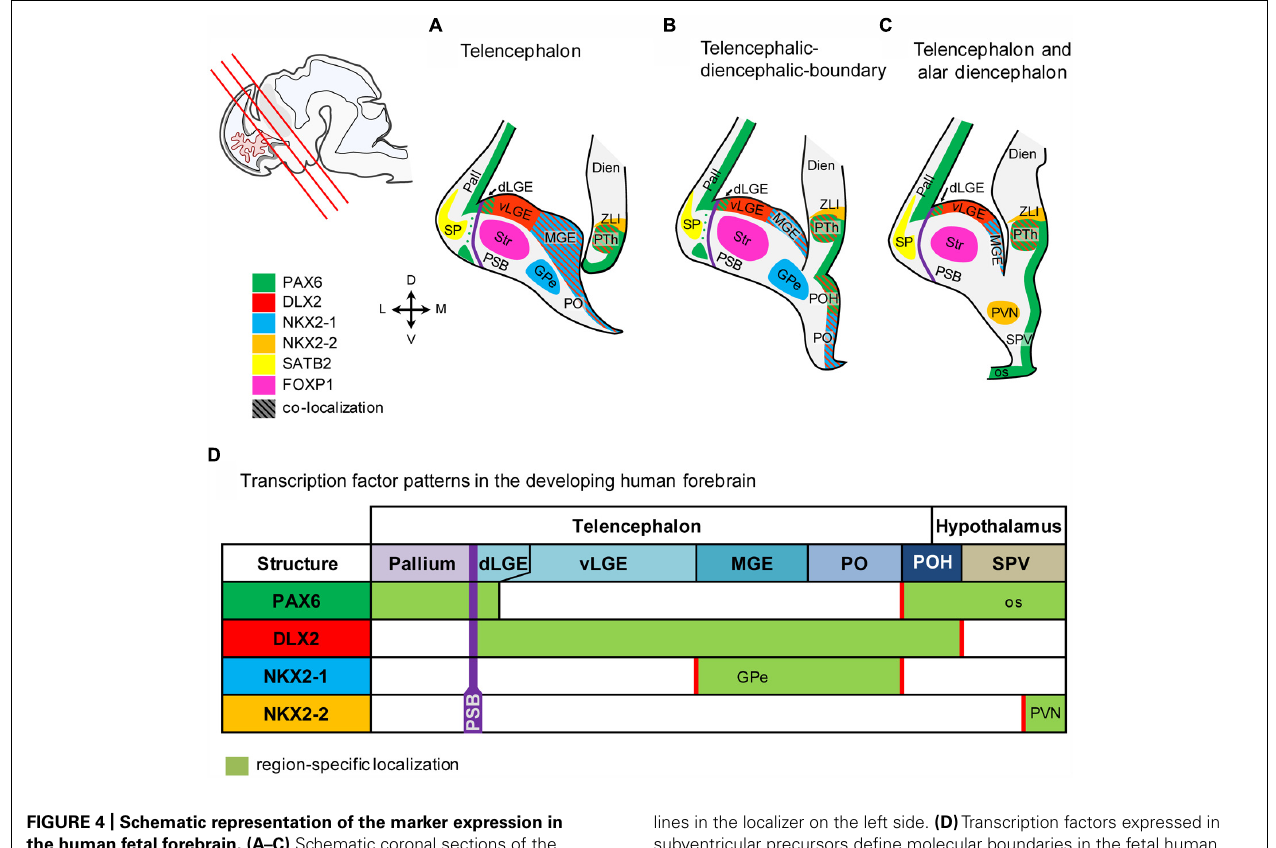
lines in the localizer on the left side. (D) Transcription factors expressed in subventricular precursors define molecular boundaries in the fetal human brain. Abbreviations see Figure 1